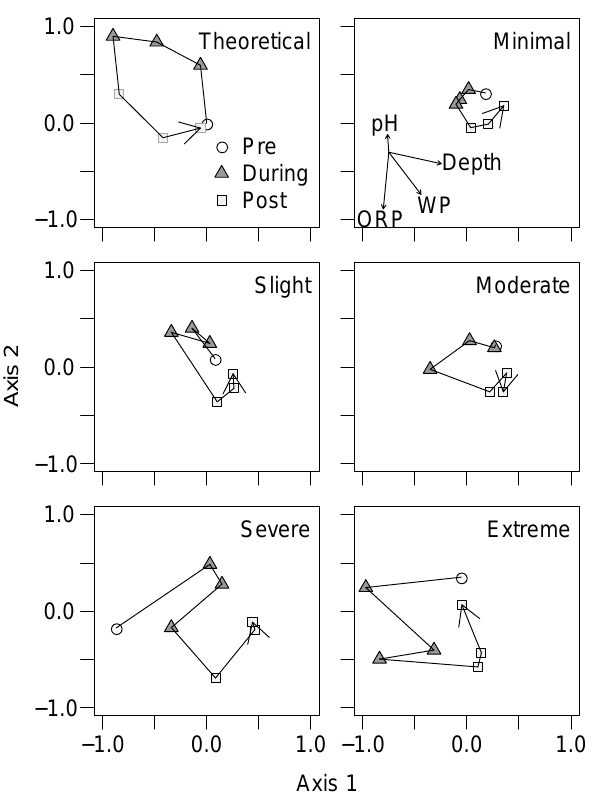
Fig. 4. Macroinvertebrate community NMS ordination, with each panel representing community trajectories through time at a given sample